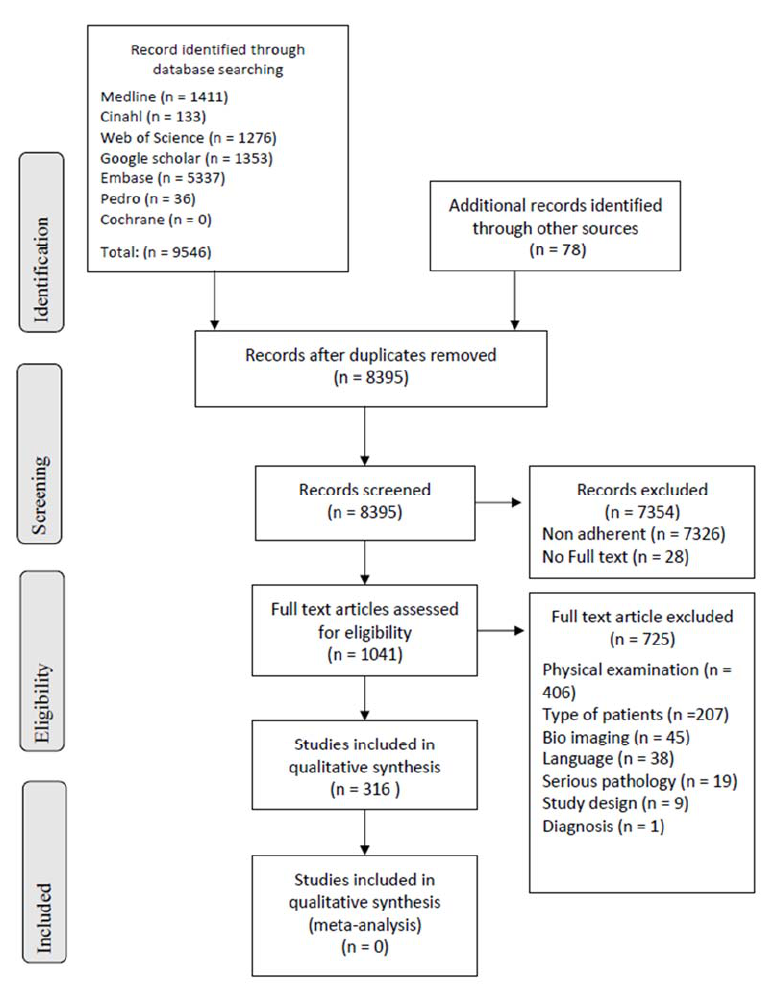
Figure 1. Flow diagram describing the selection process of the articles according to the model indicated by the PRISMA [25].